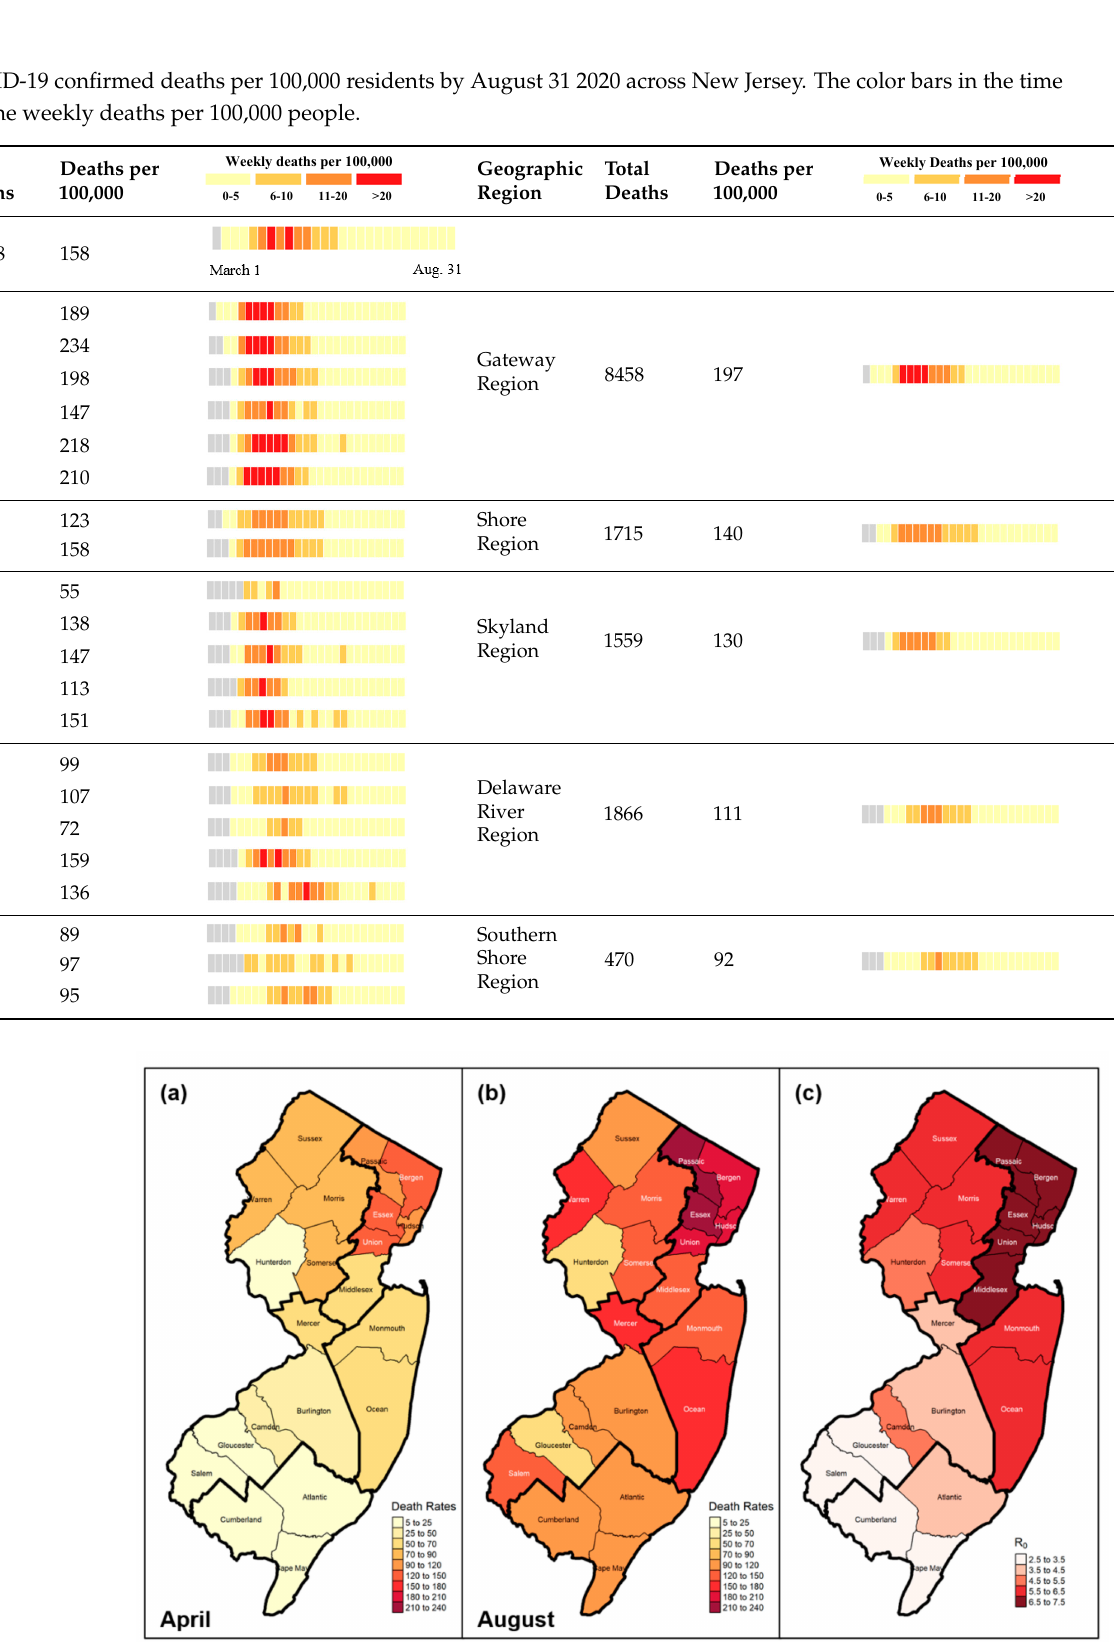
Figure 3. Spread of the COVID-19 epidemic across New Jersey: ( a ) death rates (confirmed deaths per 100,000 people) by the end of April 2020, ( b ) death rates by the end of August 2020, and ( c ) basic reproduction number (R 0 ) at the county